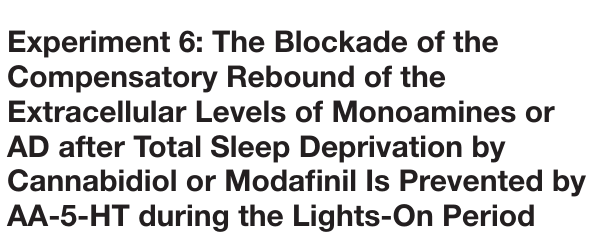
ANOVA ( F ( 6 , 28 ) = 4.474, P < 0.004), blocked the